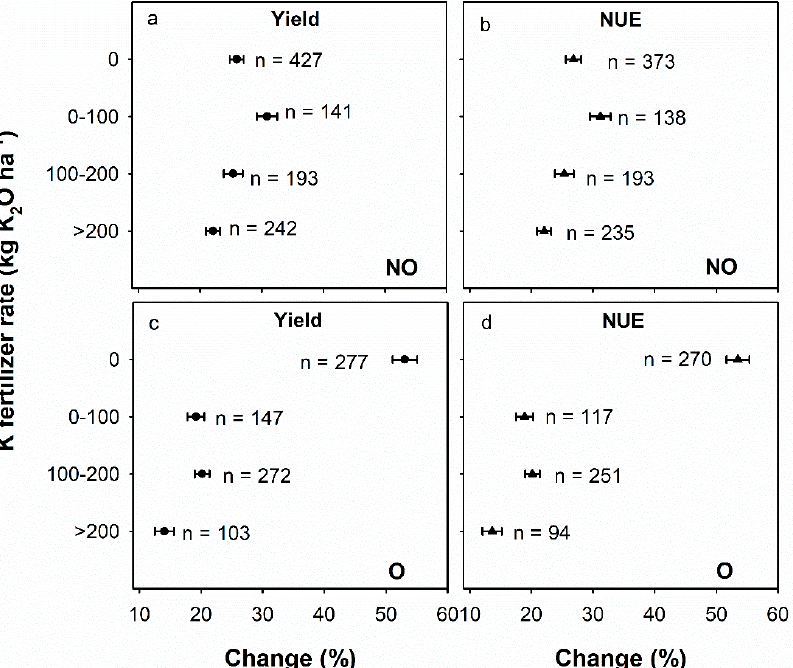
Figure 8. Response of change in potato yield ( a , c ) and NUE ( b , d ) to mulching compared to no-mulching control at different levels of potassium (K) fertilization. Error bars represent 95% confidence intervals. The values for n represent the corresponding number of observations. NO, without organic fertilization; O, with organic fertilization.